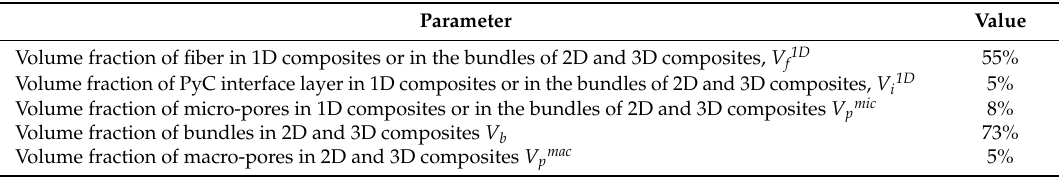
Table 7. Estimated volume fractions of the components for 1D, 2D and 3D composites.